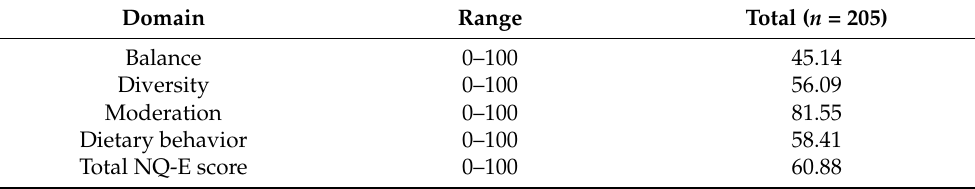
Table 4. NQ-E ¶ analysis results. Domain Range Total ( n = 205) Balance